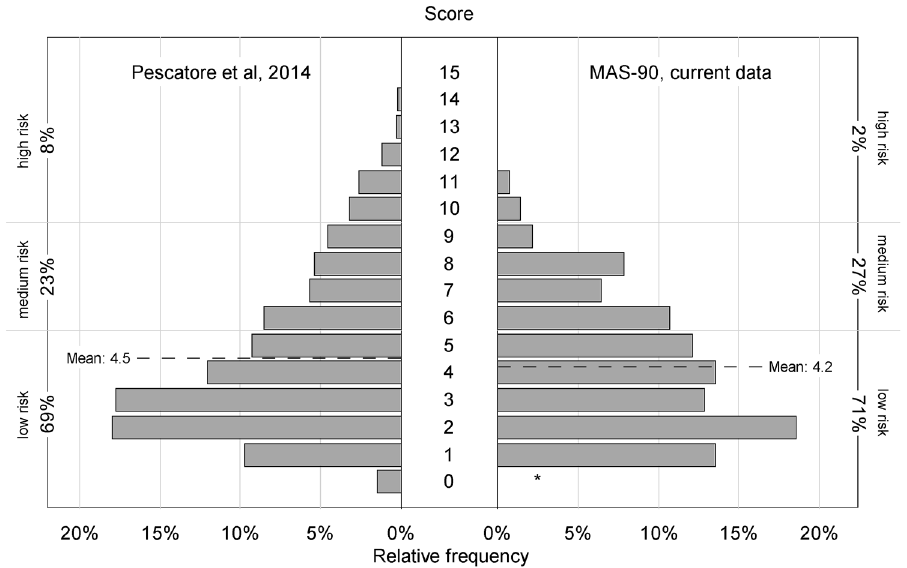
Fig. 1. Score distribution (relative frequency) from model building sample. (n 5 1226, left side, from [13]) and external validation sample (n 5 140, right side). Primary inclusion, scoring and outcome definitions. * no child with age 1 year in external validation sample (score 0 not